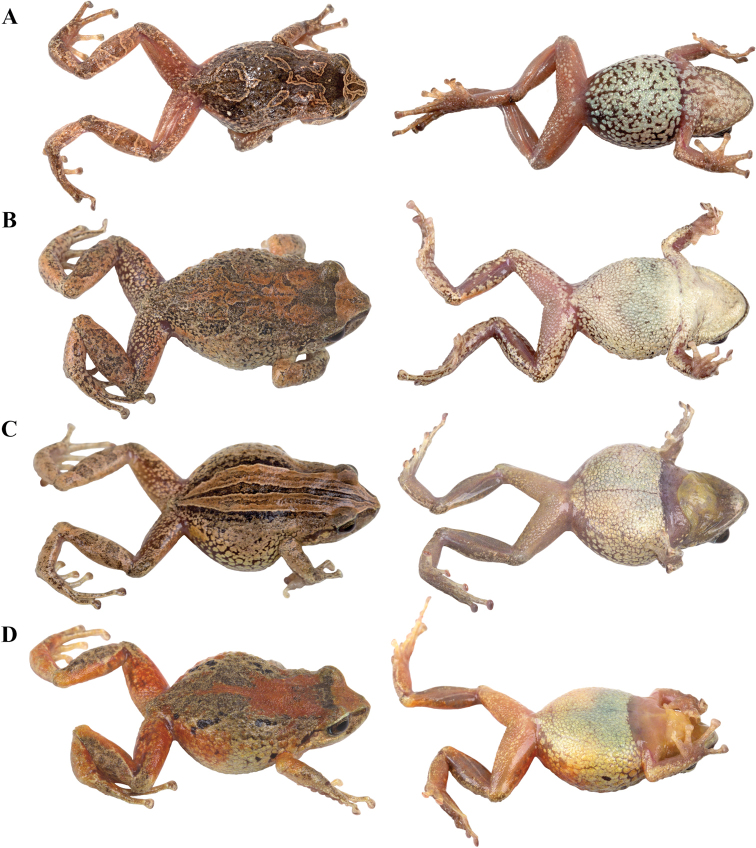
Color variation in live individuals of Pristimantis
lutzae sp. nov. AQCAZ 53728 (juvenile female, SVL 26.5 mm) BQCAZ 56183 (male, SVL 23.3 mm) CQCAZ 56184 (male, SVL 24.8 mm) DQCAZ 56185 (male, SVL 26.1 mm). Dorsolateral view on the left, ventral view on the right.